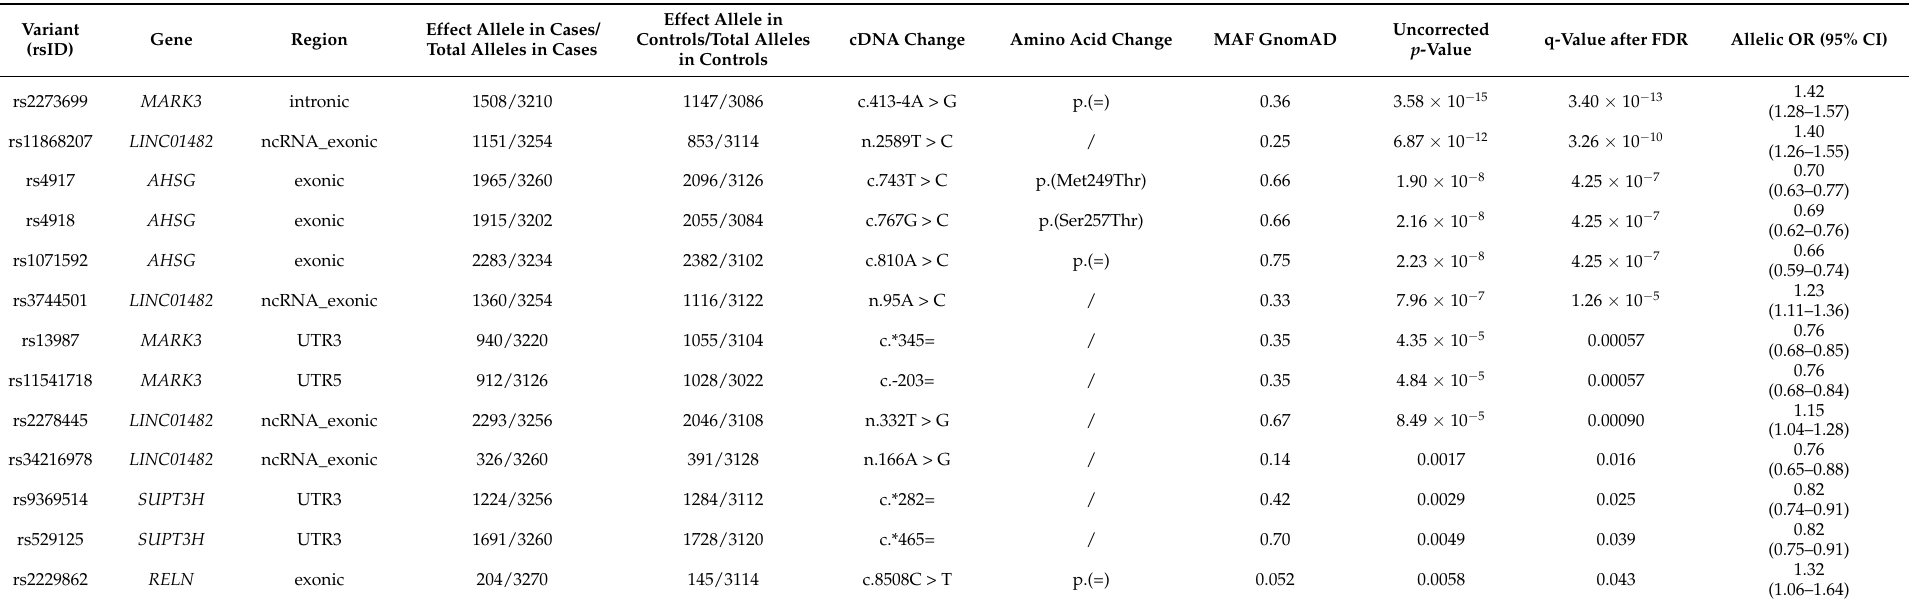
Table 1. Results of single SNP variant analysis. (The table gives an overview of all 13 significant variants after single SNP analysis with the uncorrected p -value and the corresponding q-value after false-discovery rate analysis. For each variant the corresponding rsID is given, together with the corresponding gene, region (intronic, exonic, 3 (cid:48) -UTR, 5 (cid:48) -UTR or ncRNA_exonic), cDNA change and amino acid change. Positions are given according to NM_001128918.3 ( MARK3 ), NR_110825.1 ( LINC01482 ), NM_001622.4 ( AHSG ), NM_003599.4 ( SUPT3H ) and NM_005045.4 ( RELN ). The number of effect alleles found in cases and in controls and the number of total alleles after quality control are given. Minor Allele Frequency (MAF) are given for the European, non-Finnish population, based on GnomAD v2 database. For each variant, the allelic odds ratio (OR) and the 95% confidence interval (CI) was calculated based on the number of effect and non-effect alleles in cases and